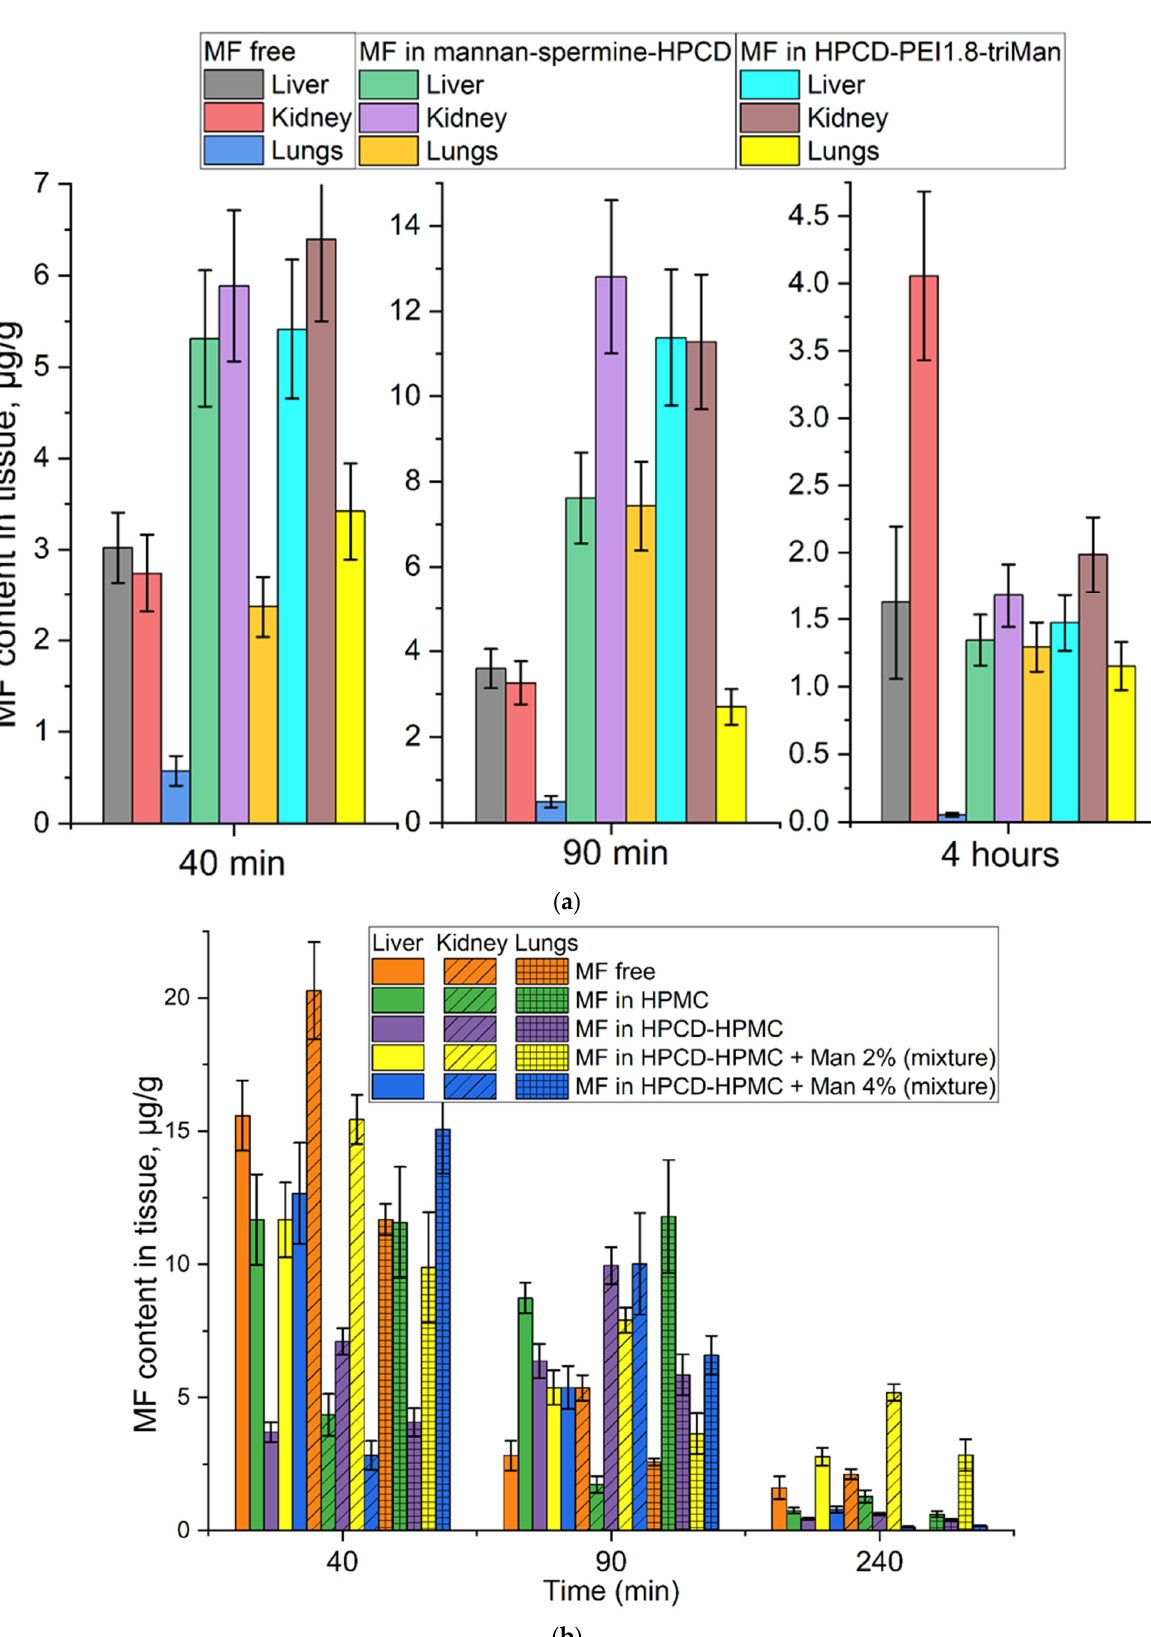
Figure 9. Biodistribution of: ( a ) MF and its formulations with mannosylated drug delivery systems in white mongrel rats; ( b ) MF and its formulations with HPMC in Wistar rats.